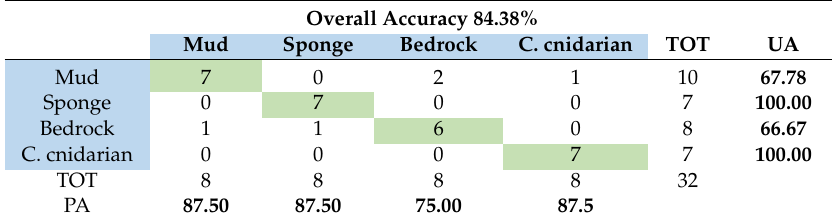
Table 3. Confusion Matrix for the CWC site classification.